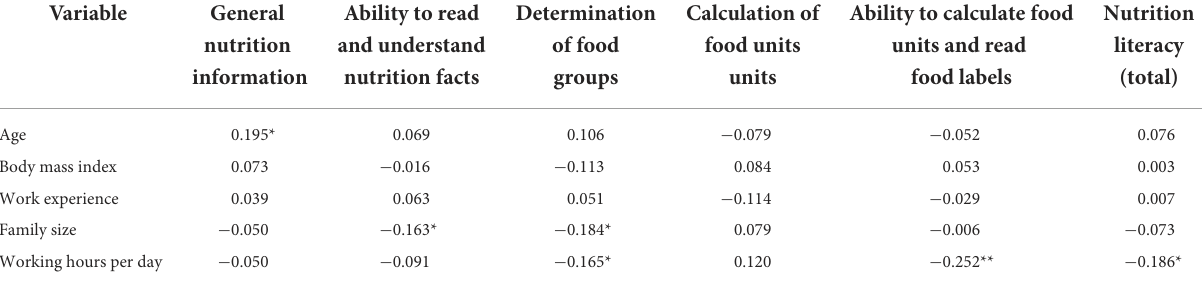
TABLE 3 Spearman’s correlation coefficients between nutrition literacy scores and its dimensions with age, work experience, family size and working hours per day. Variable General Ability to